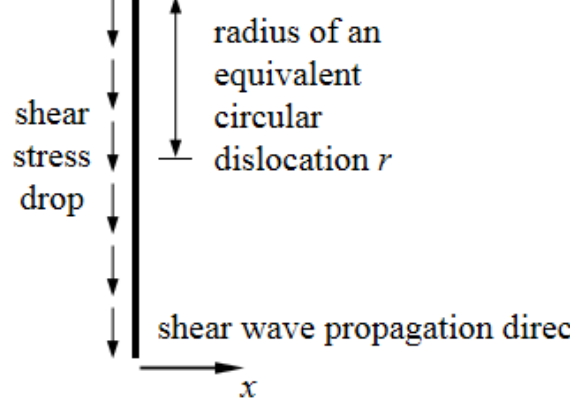
Figure 2. Schematic of the Brune source model.